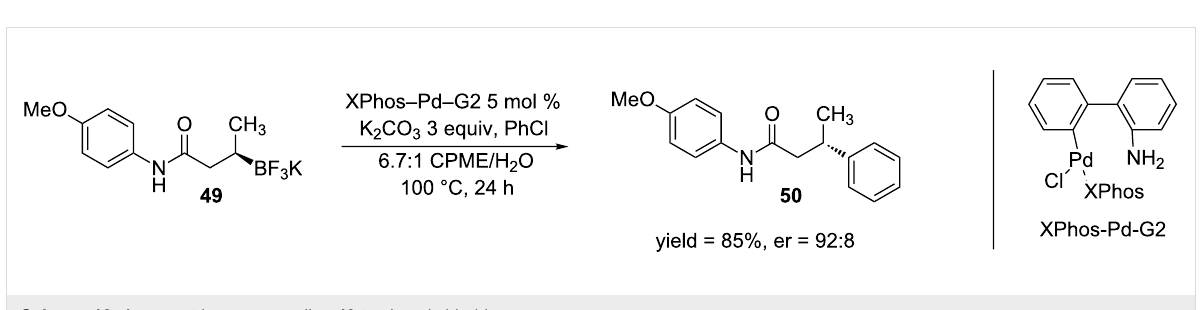
Scheme 12: Asymmetric cross-coupling 49 to phenyl